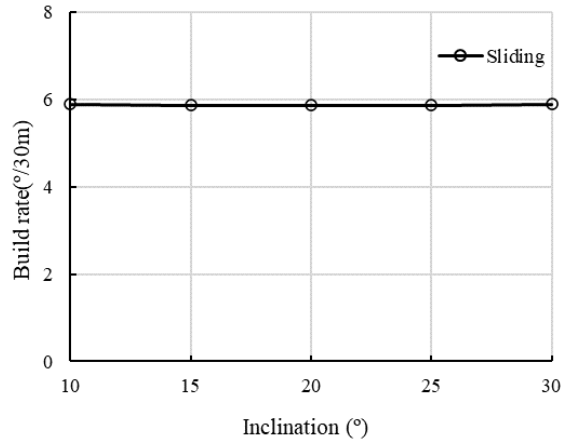
Fig. 24. Sliding build rate VS inclination